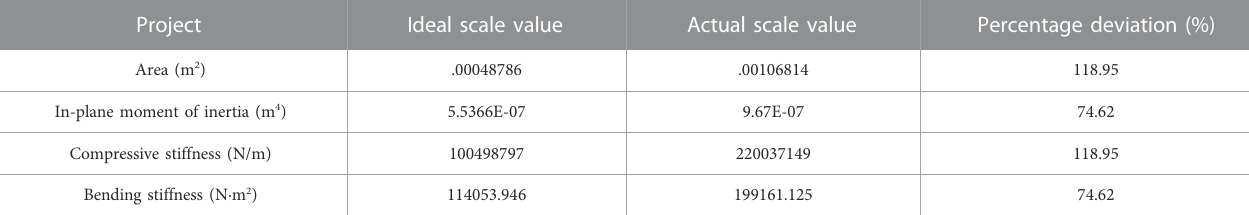
TABLE 2 Scale size